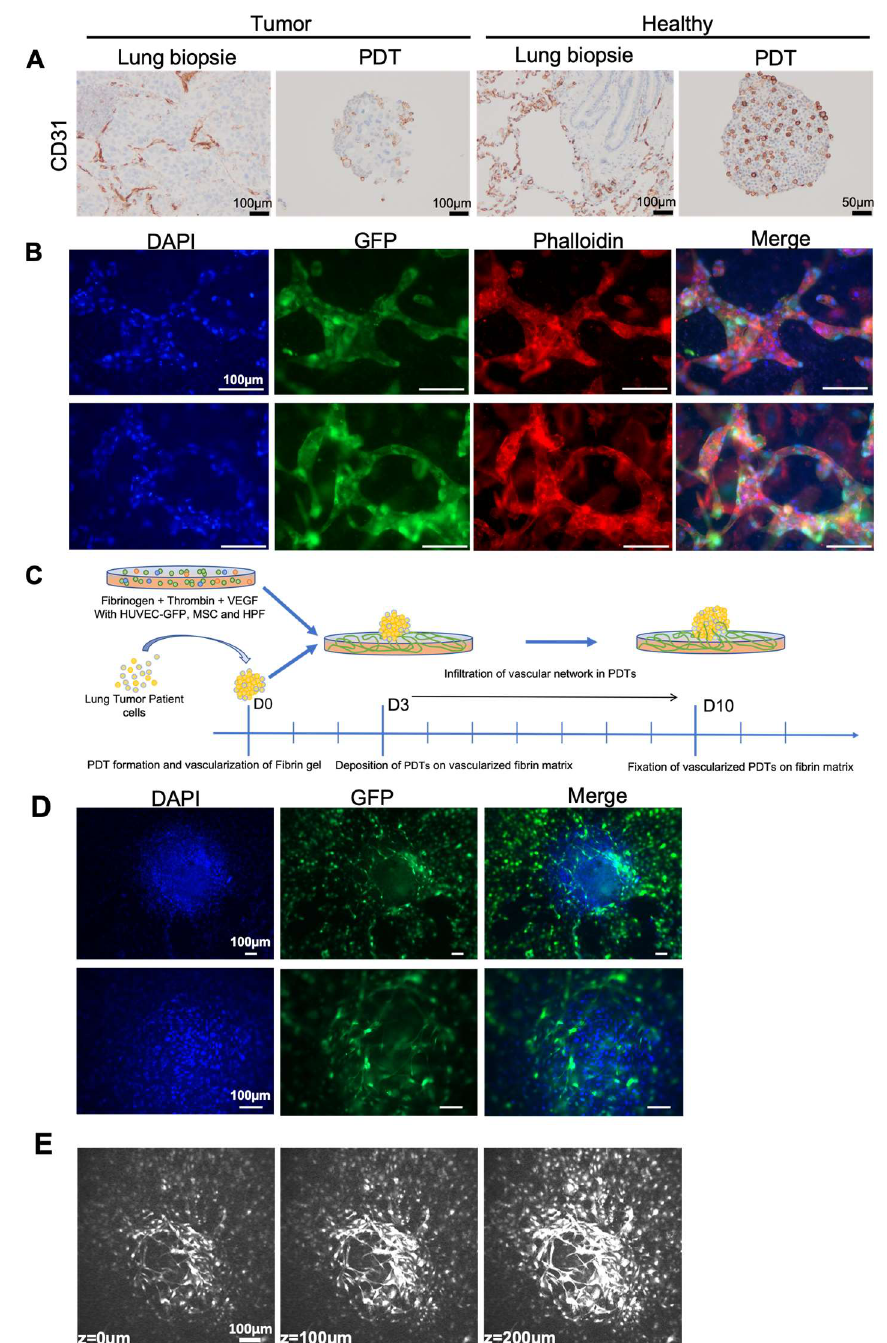
Figure 3. Endothelial cells infiltrate PDT from normal vascular microenvironment. ( A ) Immuno- histochemistry analyses performed on the lung biopsy and its corresponding PDTs with CD31 antibody. ( B ) Immunofluorescence analyses showing the vascular network developed in fibrin gel. ( C ) Experimental scheme for the combination of vascularized fibrin gel and PDTs. ( D , E ) Infiltration of endothelial cells into the PDTs. ( D ) Immunofluorescence analyses; ( E ) Confocal microscopic Z-Stack